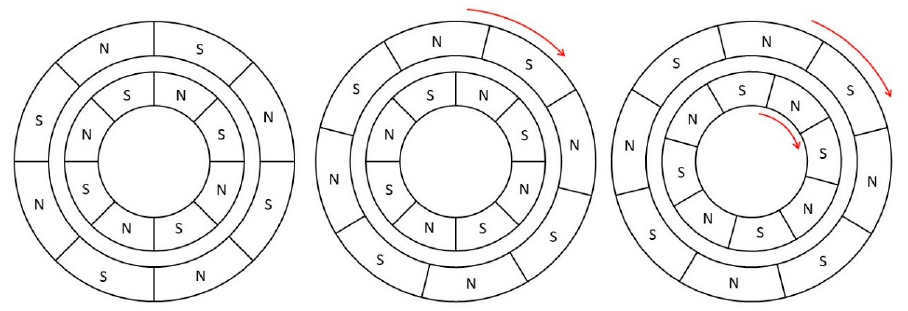
Figure 4. The static (left), starting (middle) and working (right) states of magnetic couplings.